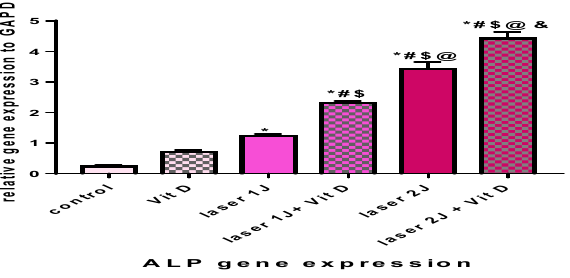
Figure 7: Osteonectin gene expression levels showed a statistically significant difference between groups (p < 0.0001). There was a highly significant difference between the laser 2 J/cm 2 + vitamin D group and laser 1 J/cm 2 + vitamin D group (p < 0.0001). Data were expressed as mean ± SD; a p-value < 0.05 was significant. (*) denotes significant difference versus control. (#) denotes significant difference versus vitamin D. ($) denotes significant difference versus laser 1 J/cm 2 . (@) denotes significant difference versus laser 1 J/cm 2 + vitamin D. (&) denotes significant difference versus laser 2 J/cm 2 .